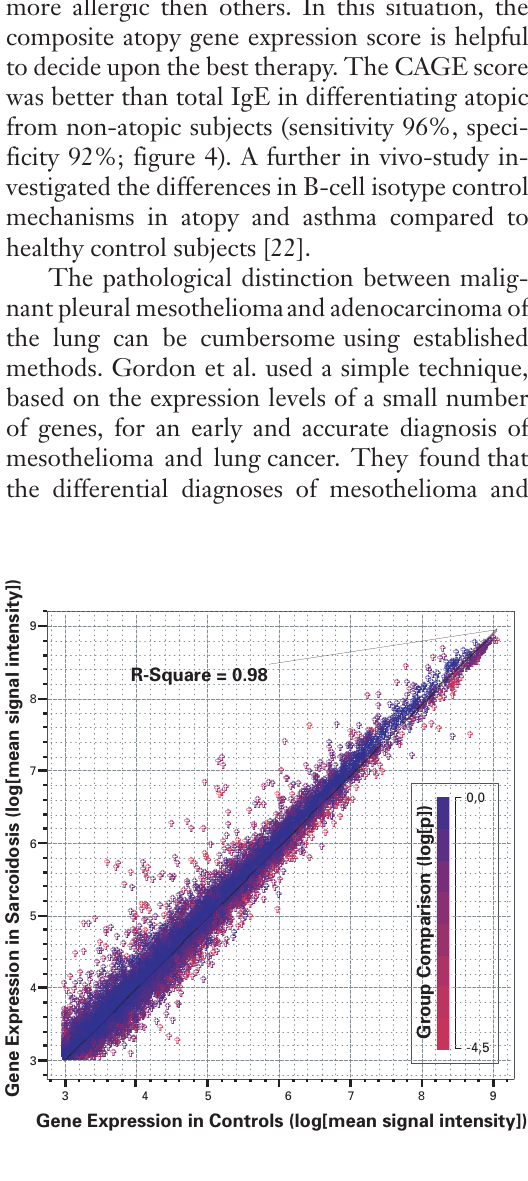
Figure 3 In a double-blind controlled trial 16 healthy in- dividuals were randomised (3:1) to either placebo or 0.5 mg/kg of body weight oral pred- nisone daily for 14 days. At baseline, and on days 1, 7, and 14, broad-spectrum gene expres- sion (GeneChip  HGU 95A, Affymetrix Inc.) in purified blood mononuclear cells was evalu- ated. Of the 12’605 genes measured, 3’520 or 28% were expressed and 450 of these or 13% were significantly dysregulated 8 h after first prednisone dose. The figure shows the signifi- cantly up- (red) and downregulated (green) genes. We could identify acute and long-term steroid-responsive genes in different metabolic pathways, which might help to characterise dif- ferences in the individual susceptibility to steroid-related side-effects